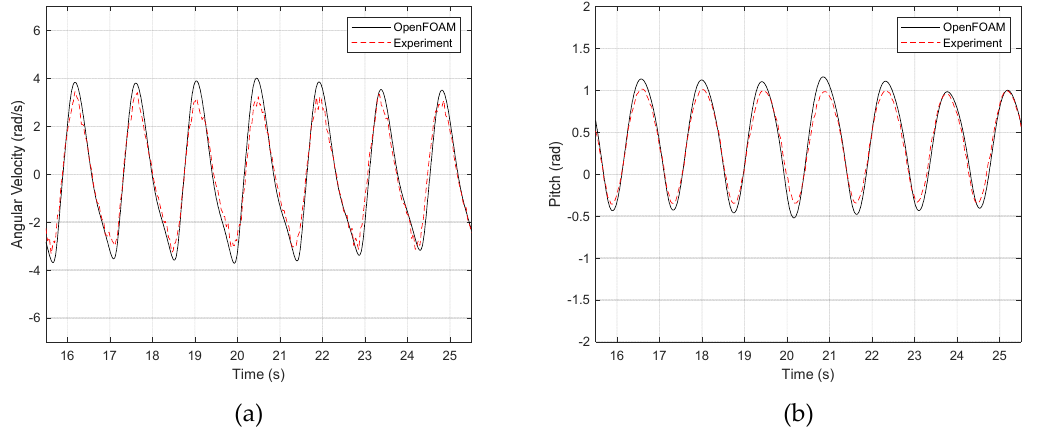
Figure 5. Comparison of time series of (a) angular velocity and (b) pitch excursion at 𝐻 = 0.136 m and 𝑇 = 1.432 s.